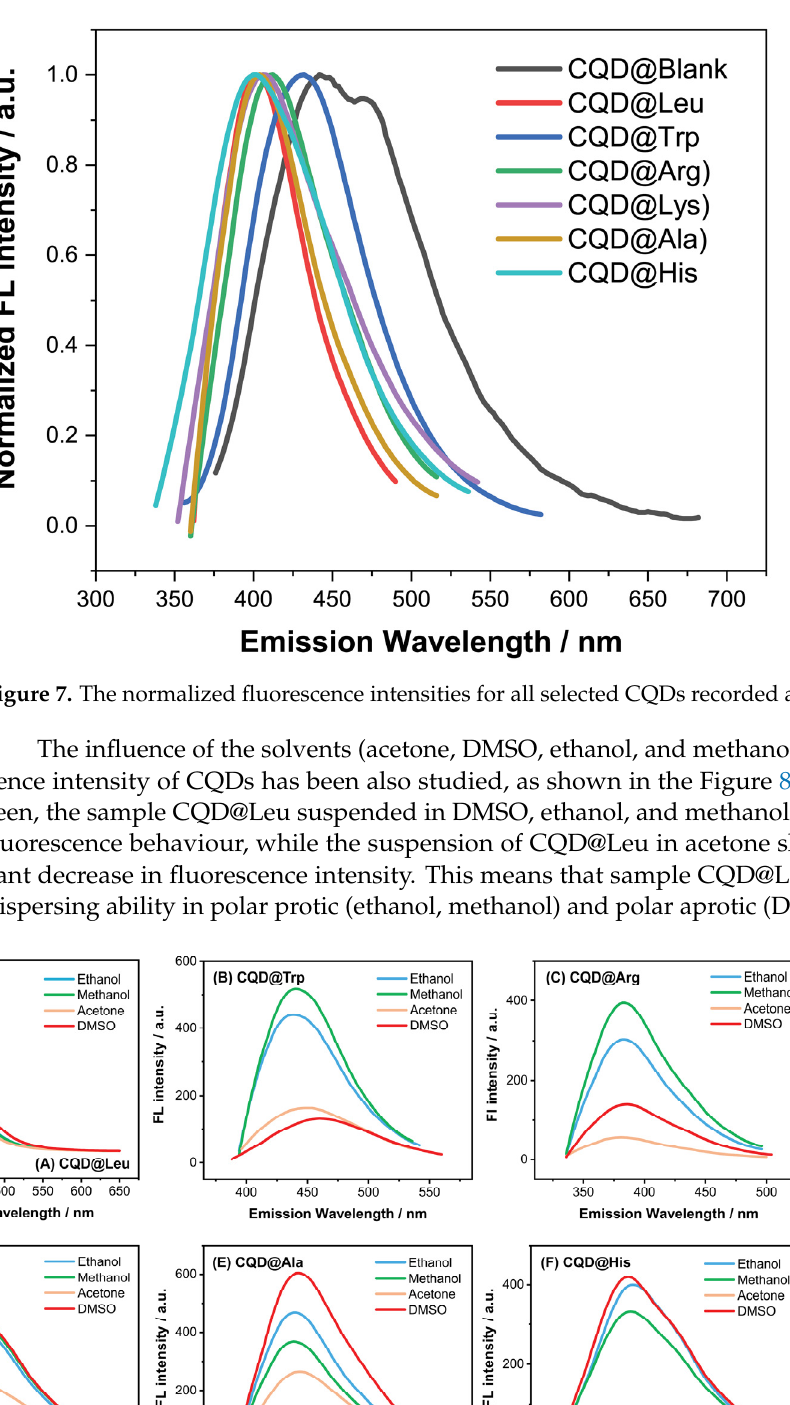
from 320 nm to 440 nm (increments of 20 nm).